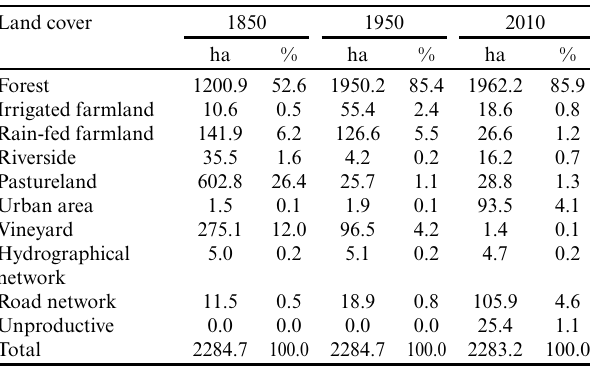
Table 1 . Land-cover distribution in 1850, 1950, and